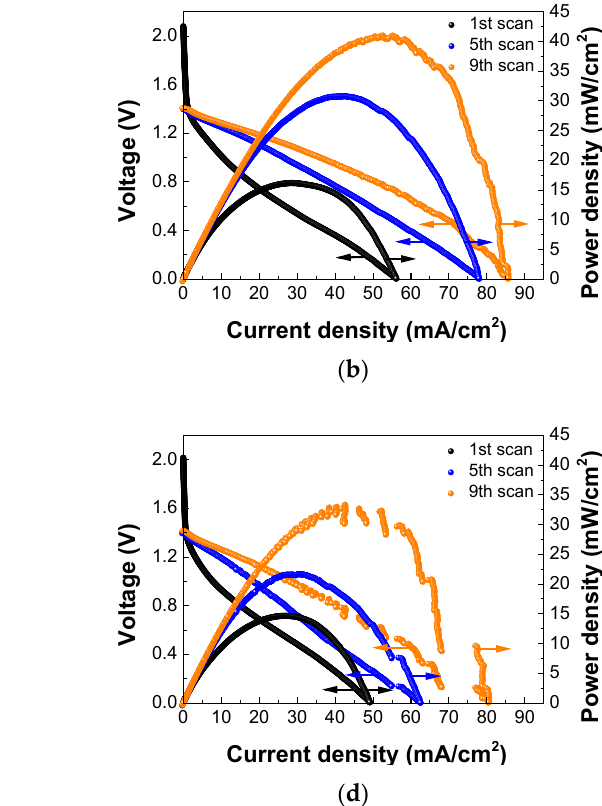
Figure 7. Polarization (V-I) and power density curves recorded at different scan numbers measured by continuous LSV. The current collector was a graphite foil ( a ) without and ( b – d ) with He DBD jet plasma treatment for ( b ) 30 s, ( c ) 1 min and ( d ) 3 min.